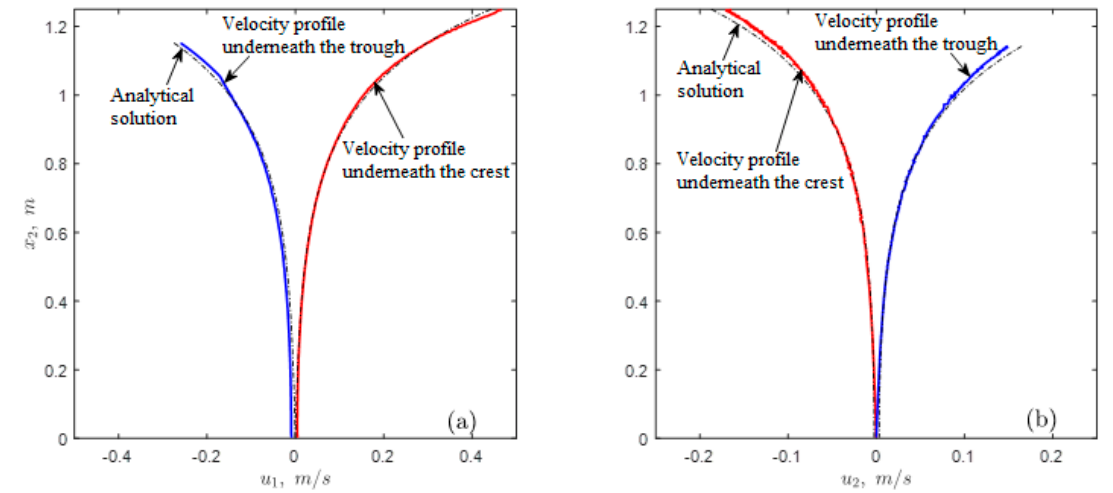
Figure 4. Comparison of the numerical solution with the analytical solution in terms of time series of horizontal ( a ) and vertical ( b ) velocities at the point corresponding to x 1 = 2.7 m and x 2 = 1.1 m during 10 periods of the wave for the fully developed flow. J. Mar. Sci. Eng. 2018 , 6 , 7